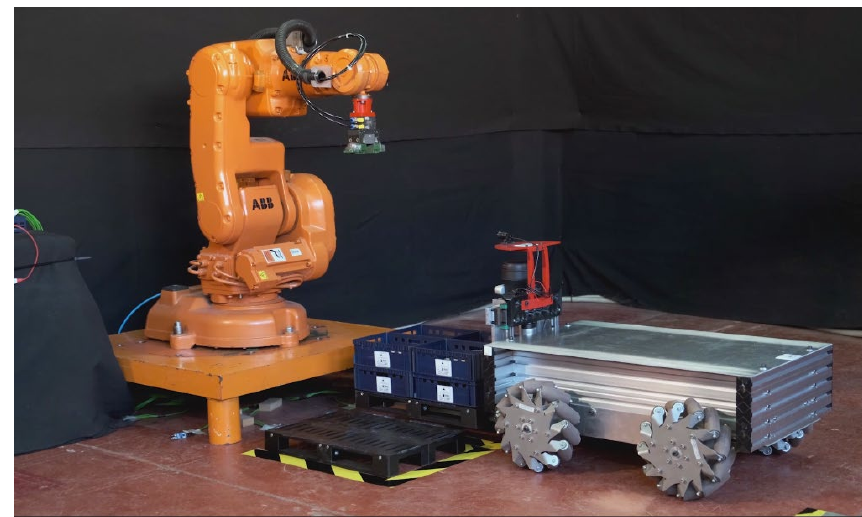
Figure 1. ABB IRB 140 robot and mobile four wheel drive robot in